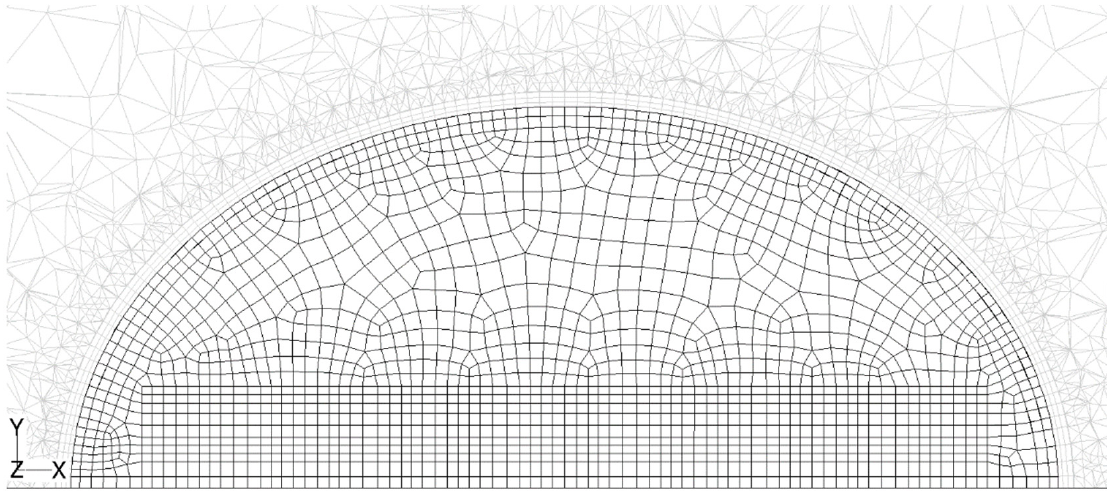
Figure 3. Computational grid of the studied greenhouse. Table 1. CFD simulation Settings.